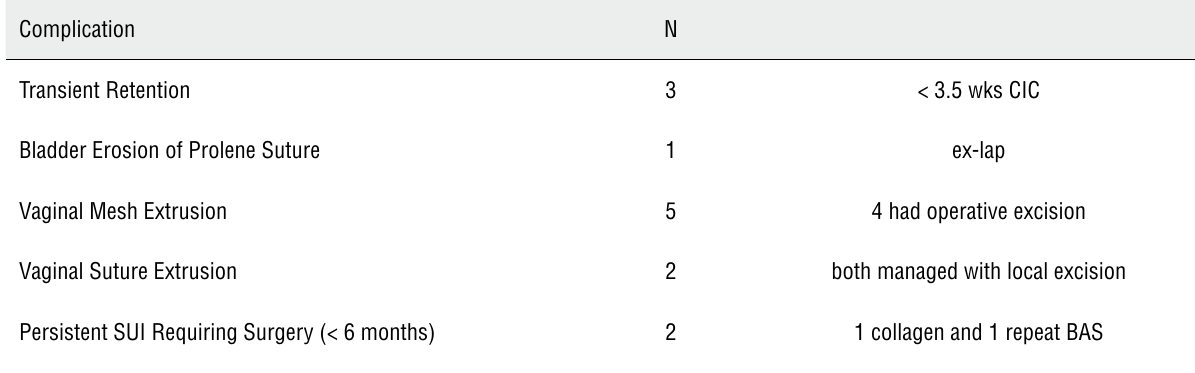
Table 2 - All complications reported in patients that underwent BAS